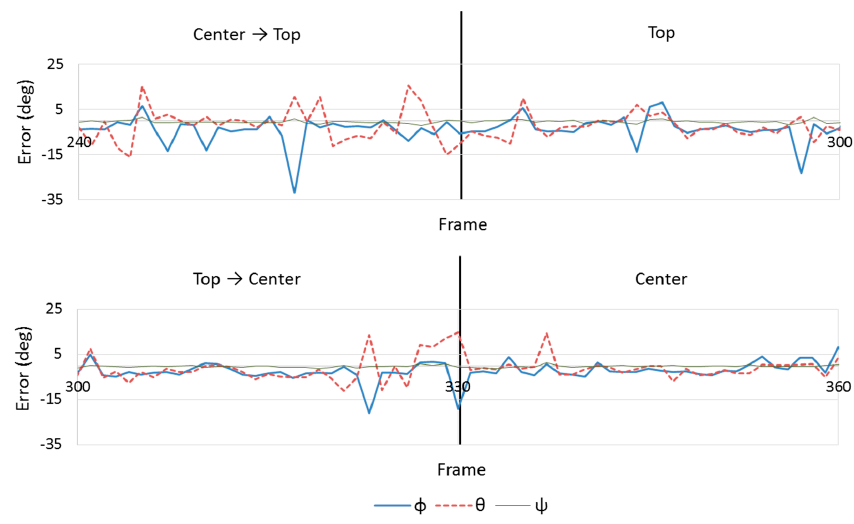
Figure 11. Rotation errors when the head was moved vertically. Table 1. Measured errors when the head was not moving. MAE: mean absolute error, RMSE: root mean square error, SD: standard deviation.